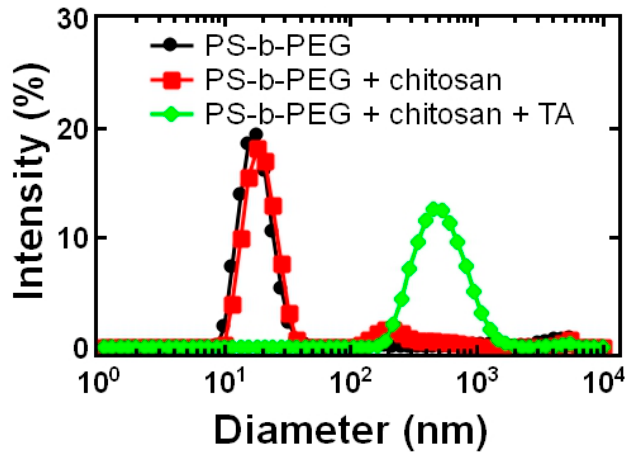
Figure 1. Dynamic light scattering (DLS) results of the block copolymer, polystyrene-b-polythylene glycol (PS- b -PEG) stabilizer that forms ~30 nm micelles (black) compared to FNP of chitosan and PS- b -PEG (red) which forms block copolymer micelles with soluble chitosan. Performing FNP with tannic acid (TA) to precipitate the chitosan with PS- b -PEG to stabilize the precipitate results in uniform particles 920 ± 150 nm with a polydispersity index (PDI) of 0.21 ± 0.02 Water was used a solvent and the nominal nanoparticle concentration of approximately 0.3 mg/mL.